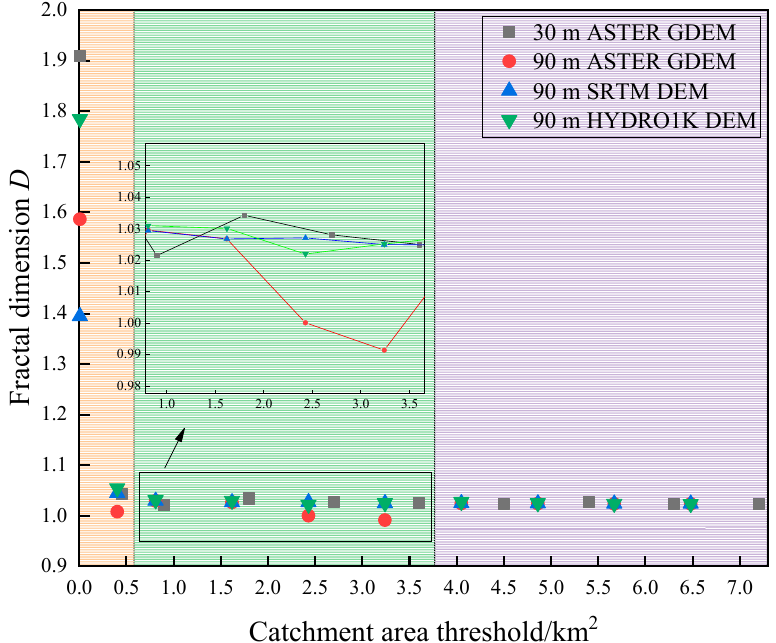
Figure 4. Fractal dimension D versus catchment area threshold.